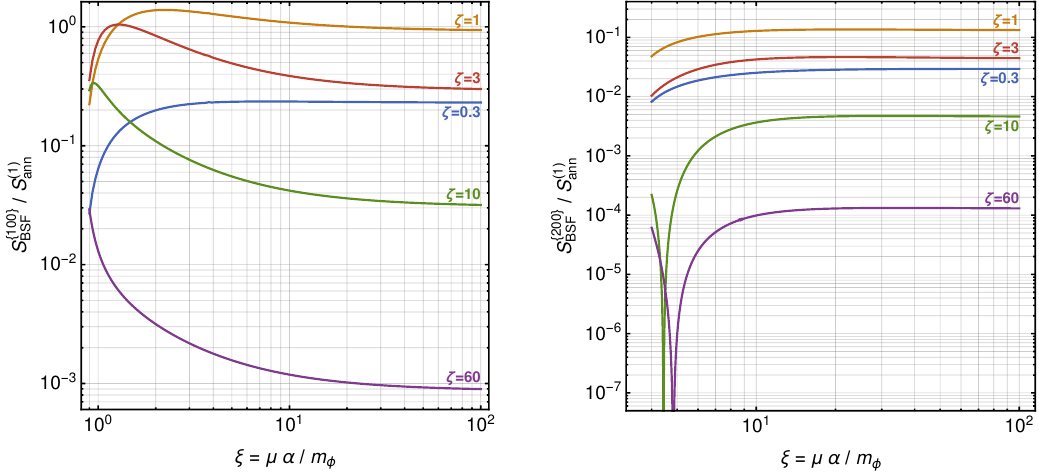
Figure 5a . The ratios S f 100 g =S (1) ann (left) and S f 200 g =S (1) ann (right), where S (1) ann ( (cid:16); (cid:24) ) is the Sommer- BSF BSF feld enhancement factor of p -wave annihilation processes, which depends on the ‘ = 1 component of the scattering state wavefunction only [cf. eq. (3.16)]. The absence of any resonances in these ratios implies that the resonances in S f 100 g and S f 200 g arise solely from the scattering-state wave- BSF BSF function. On the other hand, the anti-resonances arise from the interference of the scattering-state and bound-state wavefunctions.